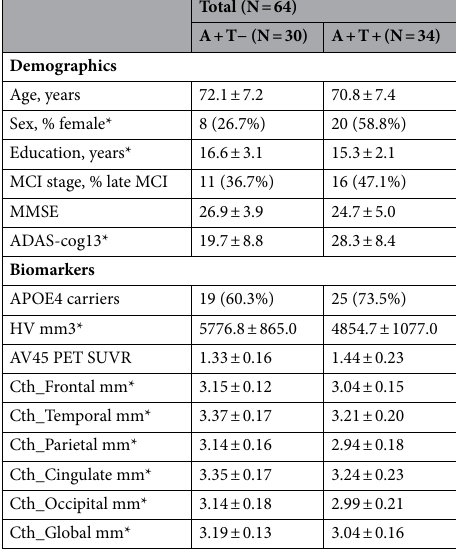
Table 1. Demographics and biomarkers of A + MCI participants. MCI mild cognitive impairment, MMSE mini-mental state examination, PET Positron emission, ADAS-cog The Alzheimer’s disease assessment scale- cognitive, HV hippocampal volume, Cth cortical thickness, A amyloid, T tau. *P < 0.05 between A + T− and A + T